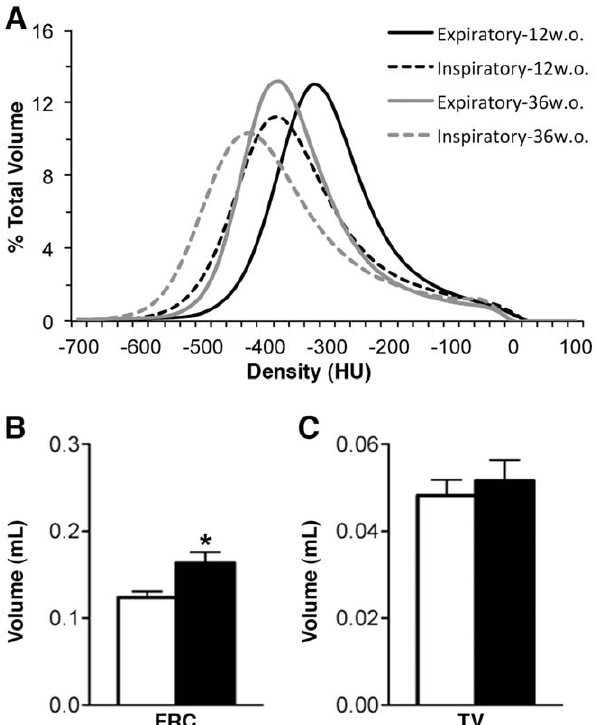
Figure 7. Respiratory-gated CT data for 12w.o. and 36w.o. groups. A Average volume standardized Hounsfield unit (HU) densitometry of expiratory (solid line) and inspiratory (dashed line) lung states for 12w.o. (black) and 36w.o. (grey) animals. B Average functional residual capacity (FRC) and tidal volume (TV), calculated from gated CT data. White bars refer to 12w.o. animals while black bars refer to 36w.o. animals. ***p , 0.001 by two-tailed t-test.